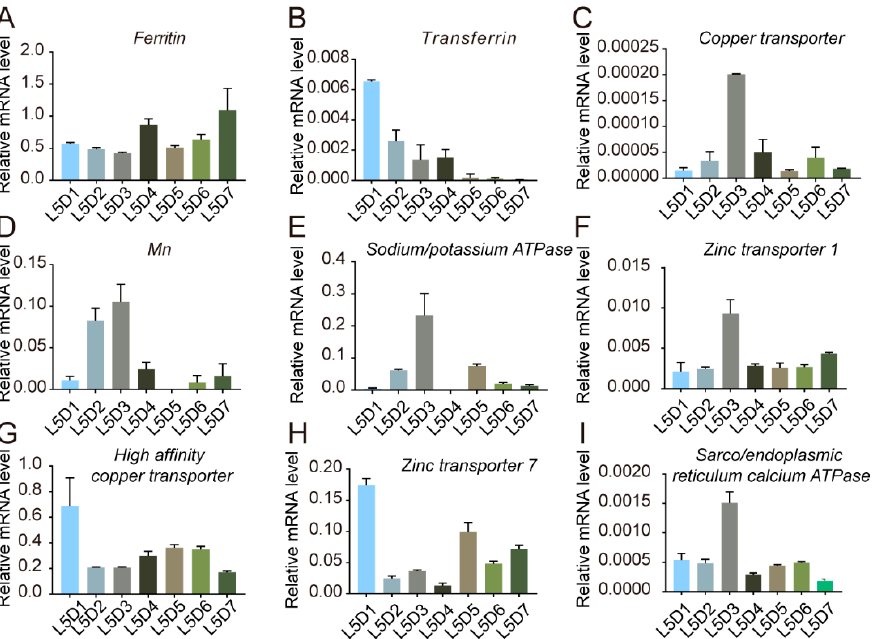
Figure 7. Expression profiles of metal ion-related genes in the anterior silk gland of the fifth instar larvae. ( A – I ) Transcript levels of different metal ion-related genes; L: larva; D: day; error bars show SD.